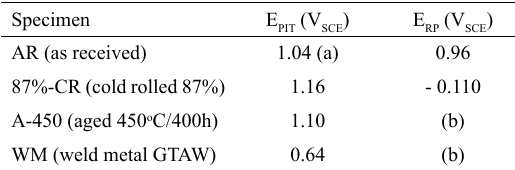
) and repassivation potentials (E PIT